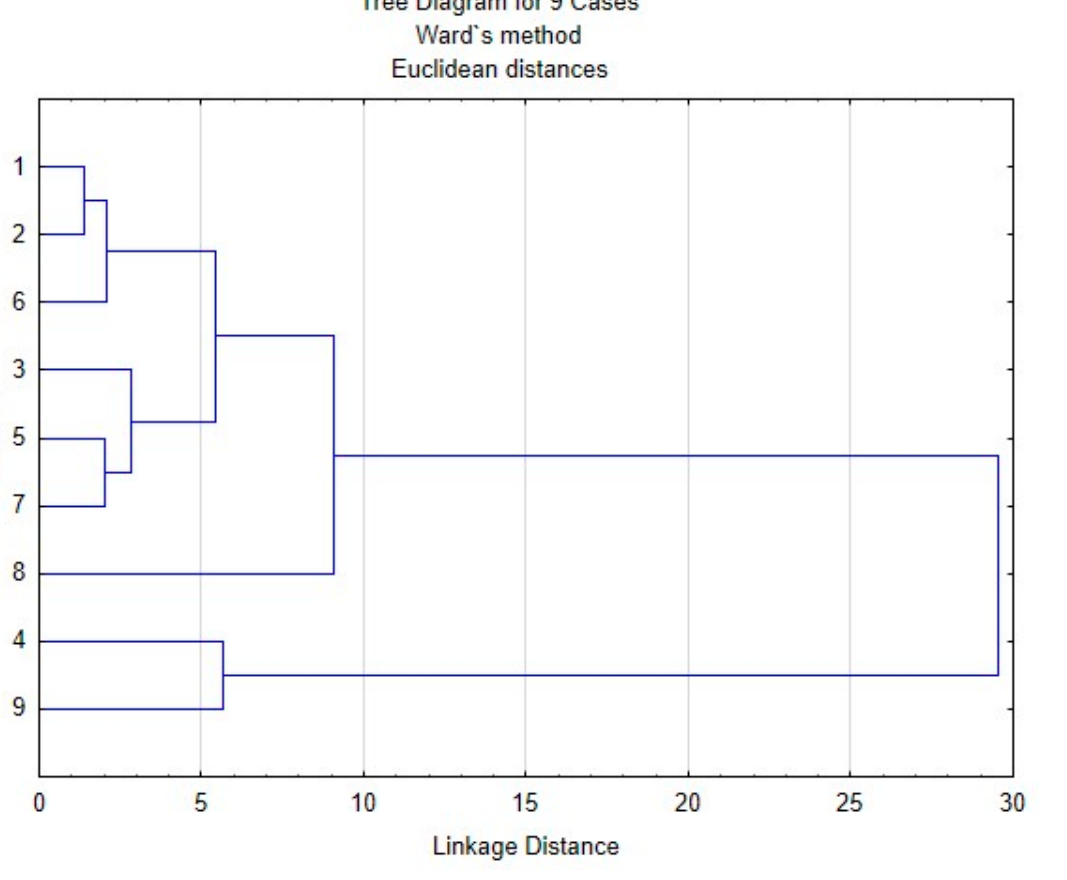
Figure 8. Hierarchical clustering: Ward’s method.